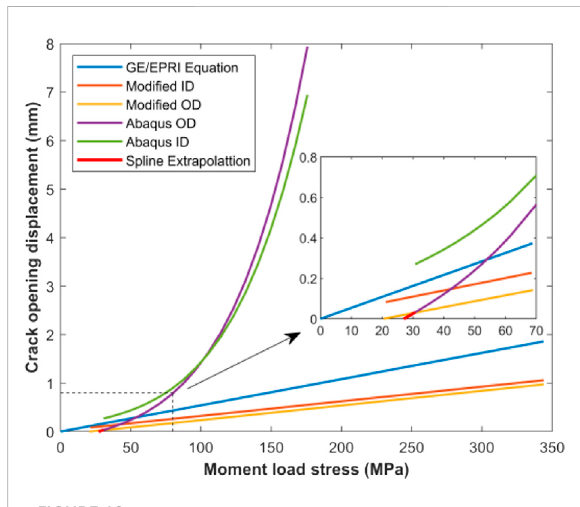
FIGURE 18 Validation of the GE/EPRI and NUREG/CR-6837